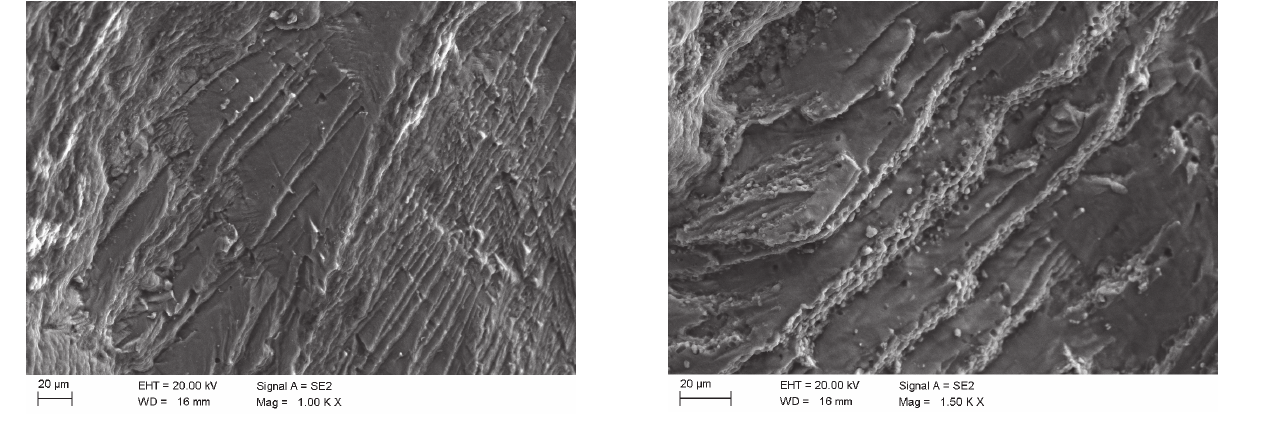
Figure 12: Trace of plastic deformation on cleavage surface of AlZn6Mg0.8Zr